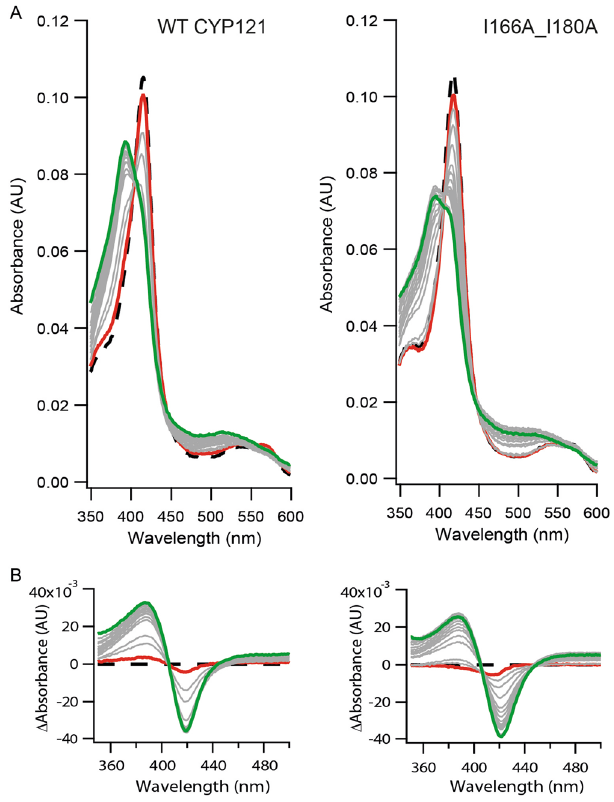
Figure 3. Spectral binding of cYY with WT and I166A_I180A CYP121A1. ( A ) cYY titration between 0 and 1050 µM produces a shift to 395 nm (green traces). ( B ) Subtracted spectra of cYY binding. Spectral binding plots were generated using Igor Pro Version 6.37 (https ://www.wavem etric s.com/) and graphics designed by Adobe Illustrator CS5 (https ://www.adobe .com/).